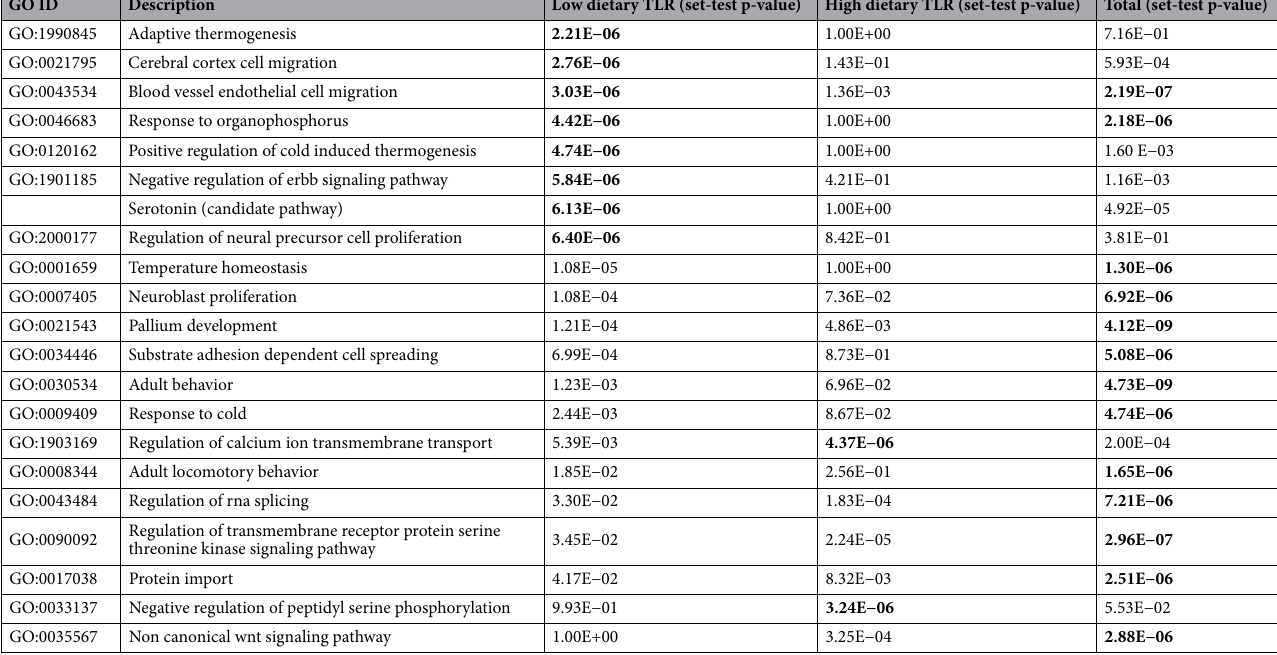
Table 3. Pathway-level associations with depressive symptoms for the 20 most significant GO terms. Values represent set-test p-values with regression-based set size correction. Values in bold indicate significant associations surviving pathway-level correction for GO terms (p <